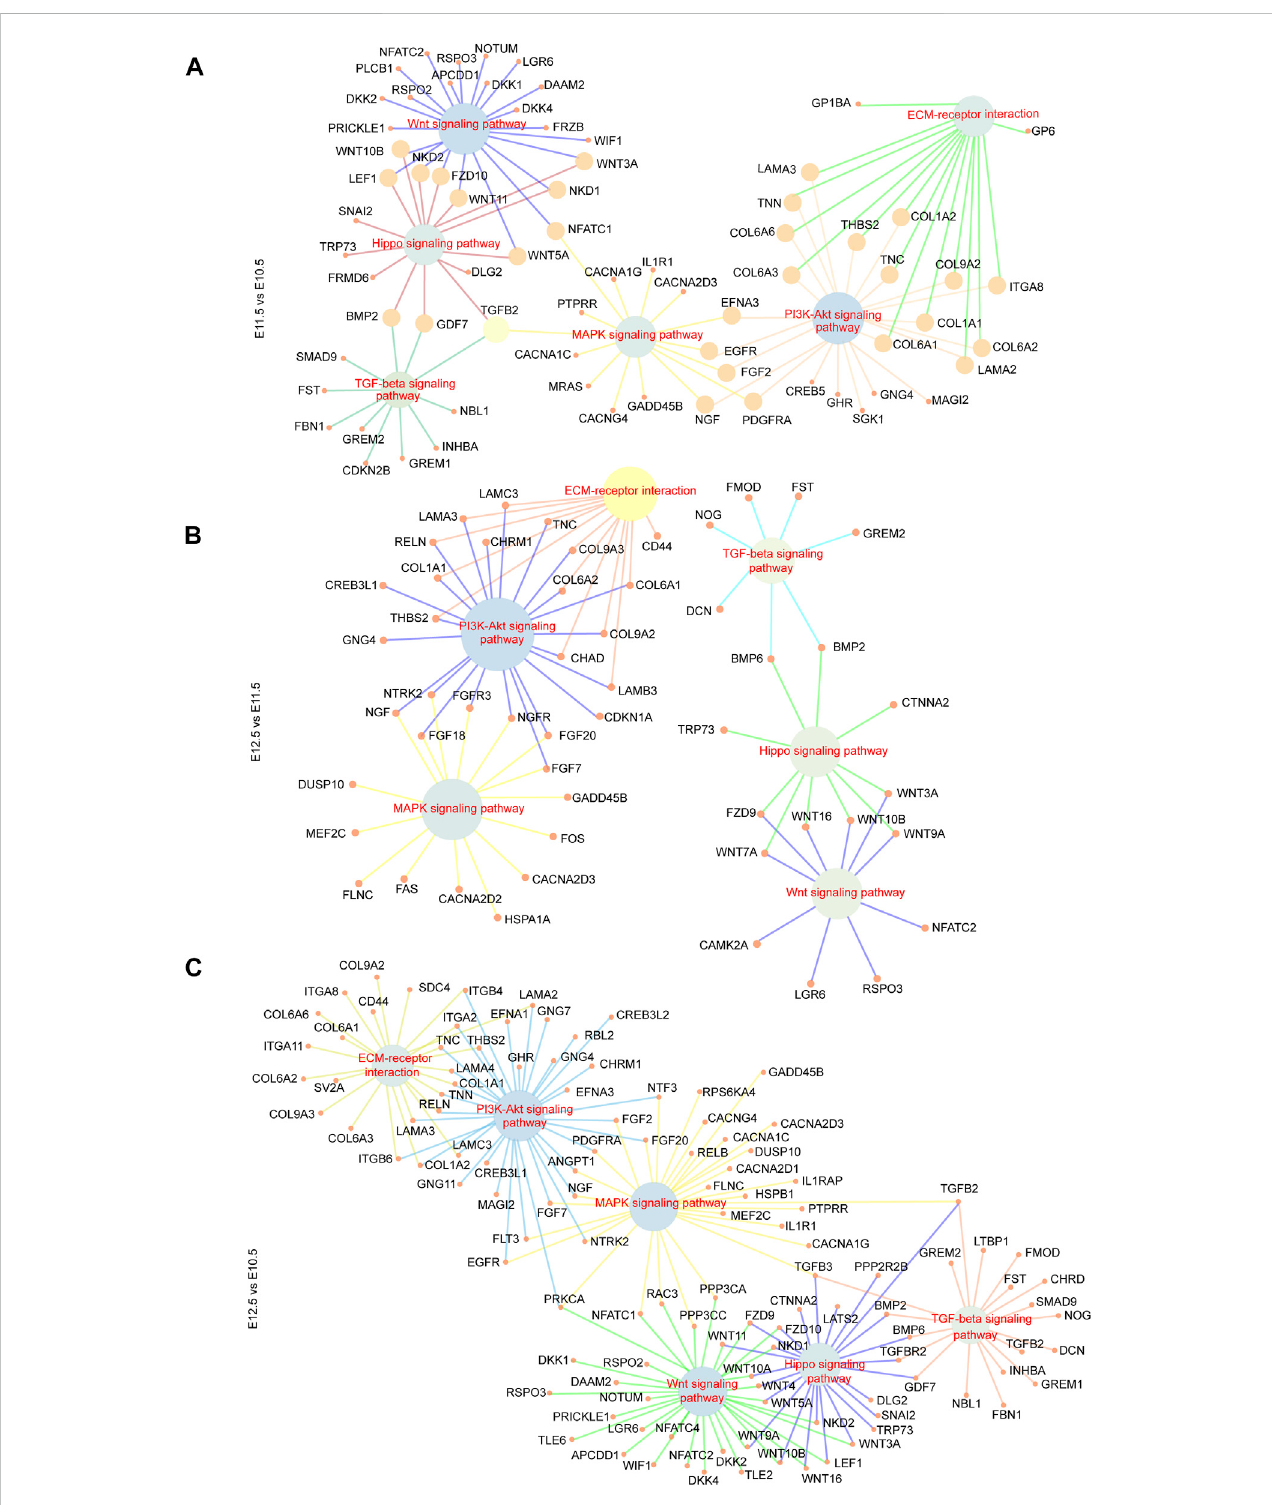
FIGURE 4 Signal-gene interaction network. DEGs and signi fi cant signal pathways playing essential roles during upper lip and primary palate development among comparisongroups (A) E11.5vs.E10.5, (B) E12.5vs.E11.5,and (C) E12.5vs.E10.5werechosen,andpro fi ledbyconstructingsignal-genenetworks,respectively. Inner nodes: signal pathways; surrounding nodes: genes; lines between inner and surrounding nodes: interactions between signaling pathways and